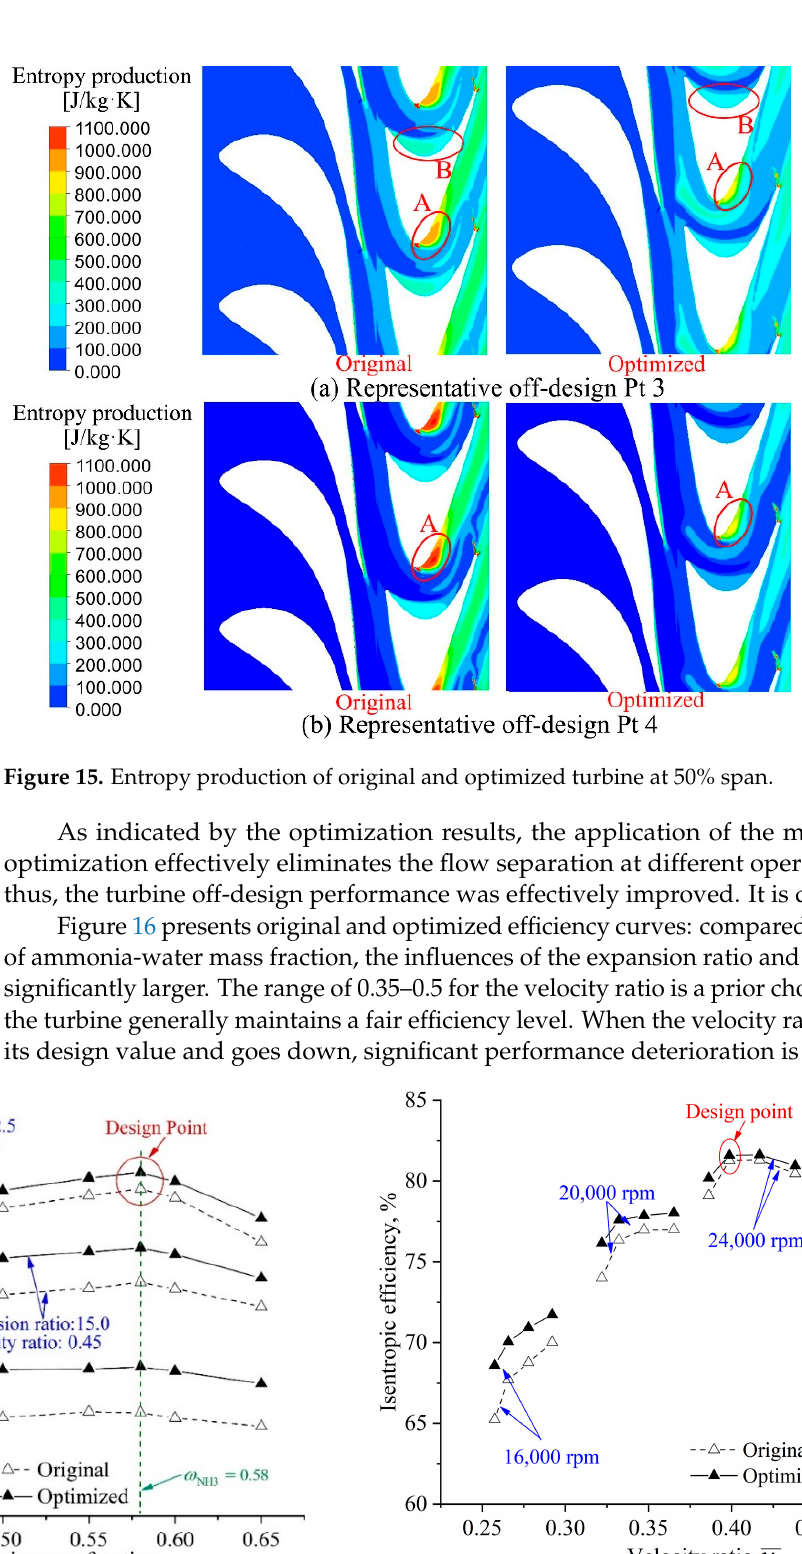
Figure 14. Streamline of original and optimized turbine at 50% span.